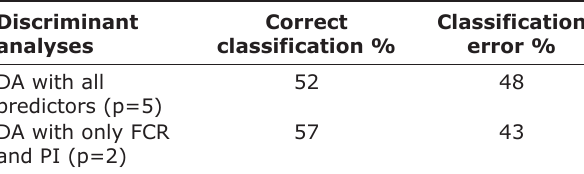
Table-7: Classification results with the percentages of correct and incorrect classification. Discriminant